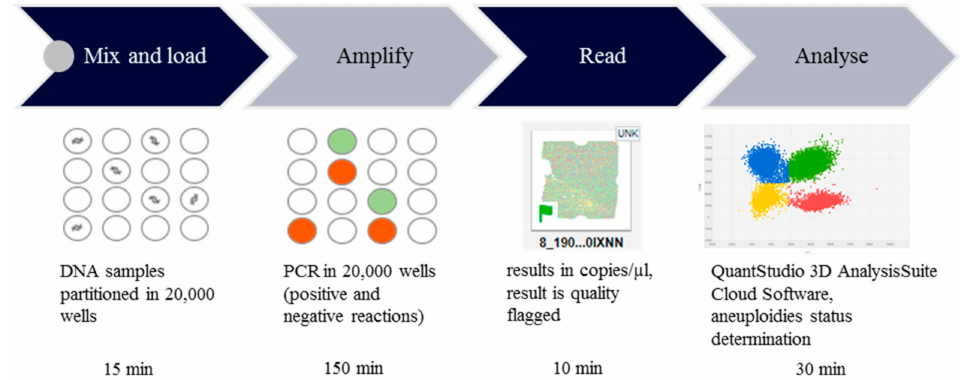
Figure 1. Workflow of the chip-based digital PCR experiment. Workflow of chip-based digital PCR (dPCR) is based on four stages: PCR reaction mix preparation, seal and load chips, PCR amplification and fluorescence detection. Data analysis with quality control was performed and aneuploidies status was determined. Results are obtained within 4 h. The small gray circle corresponds to the pipetting step at the beginning of the procedure. The circle with wavy line represents the DNA partition in the wells on the chip. The green and orange circle indicate the positive and negative PCR reactions. Three colors in the plot corresponds to the FAM signal (blue), VIC signal (red), both FAM and VIC signal (green) and no signal